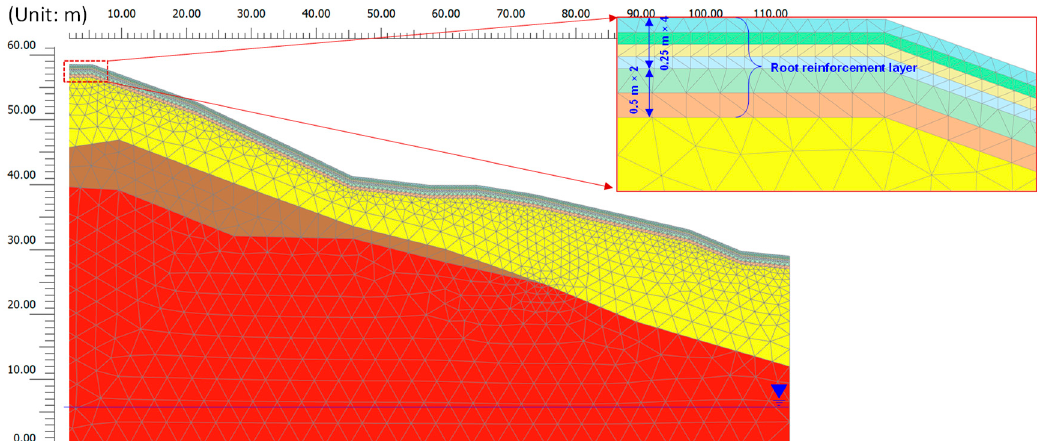
Figure 5. Mesh distributions with the root reinforcement of the numerical model. Table 3. Parameters for Van Genuchten function of the three